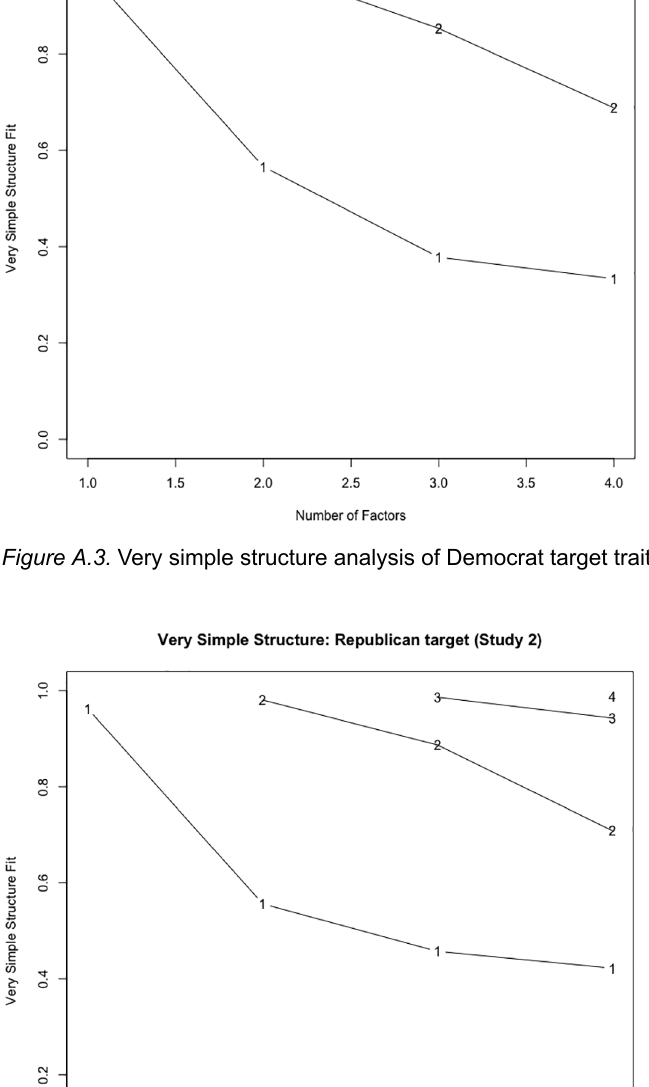
Journal of Social and Political Psychology 2019, Vol. 7(1), 213–245